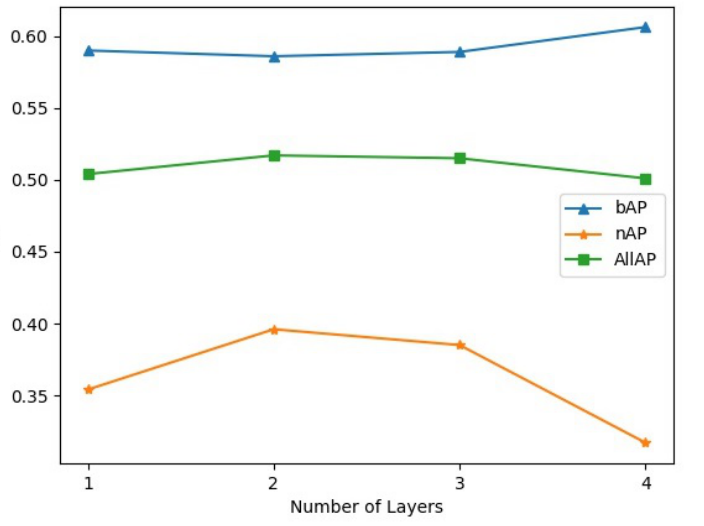
Figure 7. The effect of different GCN layer number on performance of base classes, novel classes, and all classes. The average precision on these three types of class sets are denoted as bAP, nAP, and AllAP,